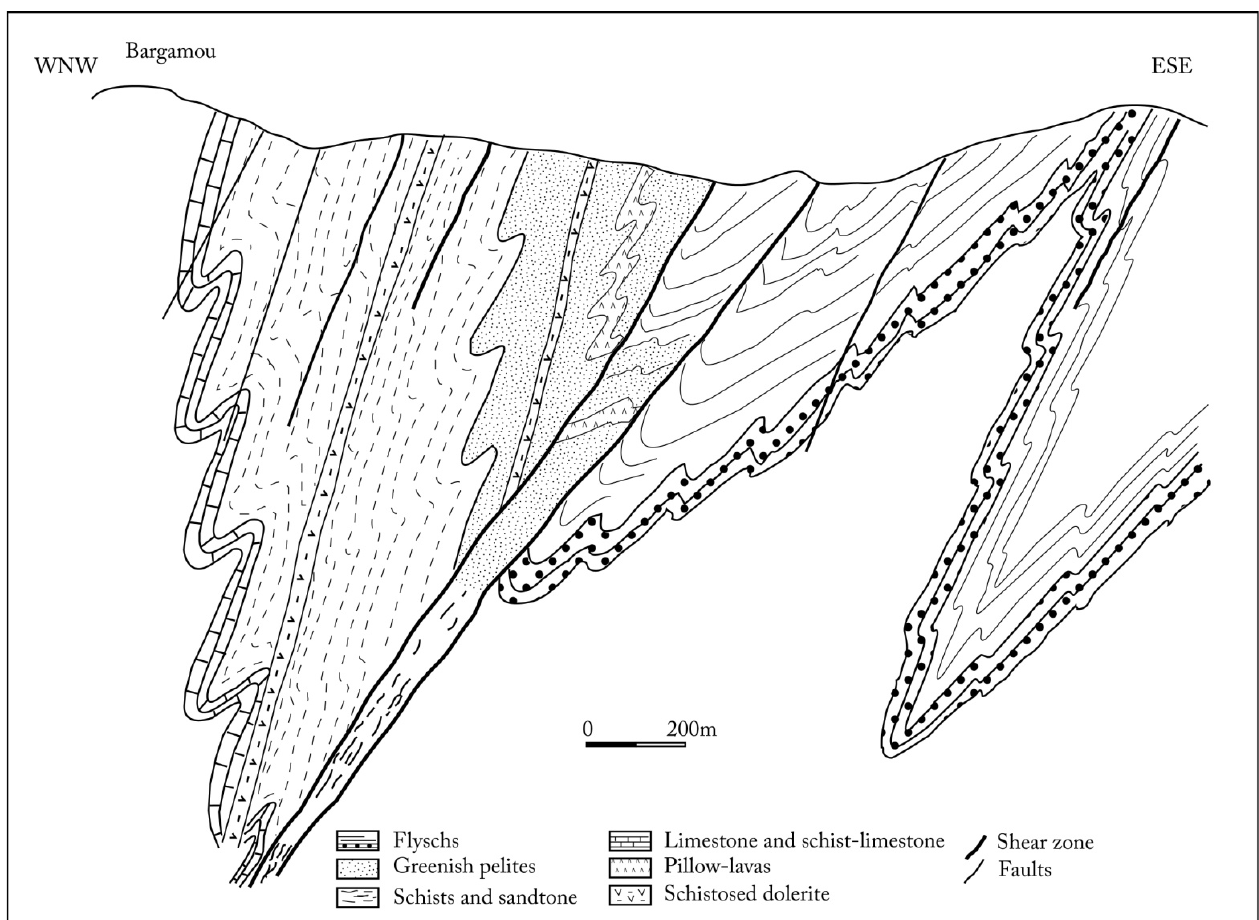
Figure 11. WNW-ESE section interpreting the structure of the NNE Achemmach [ 56 ].